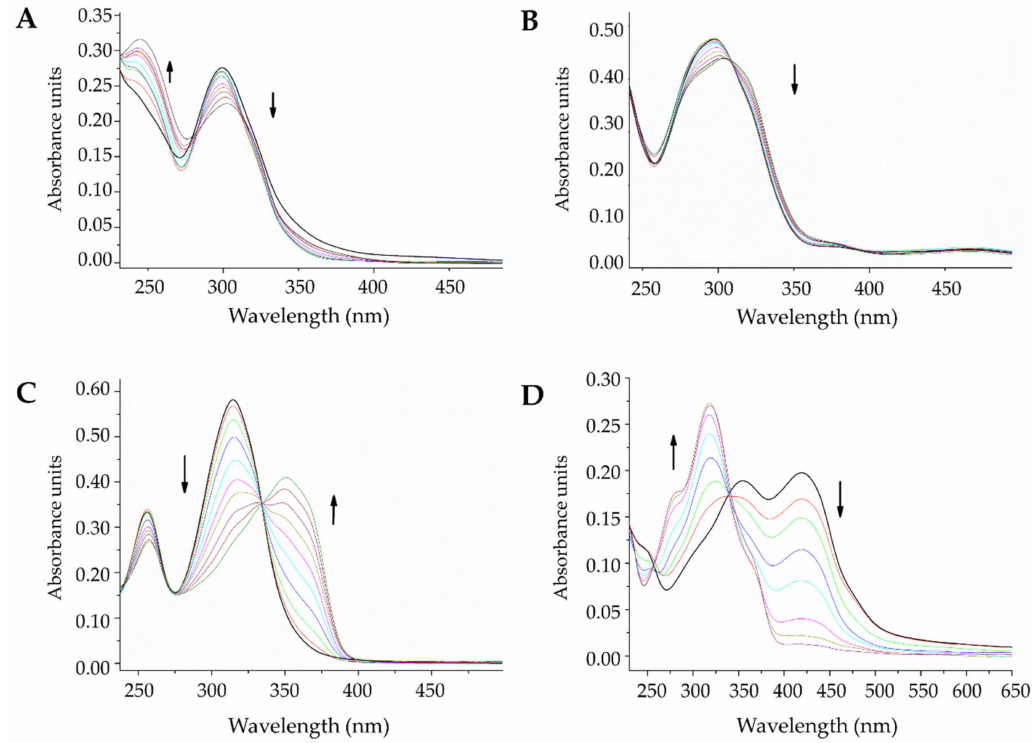
Figure 5. Photometric study at 60 µ M of ( A ) L1, ( B ) L2, ( C ) L3, and ( D ) L4, with CT-DNA at concentrations between 0 and 96 µ M (solid black line = 0 µ